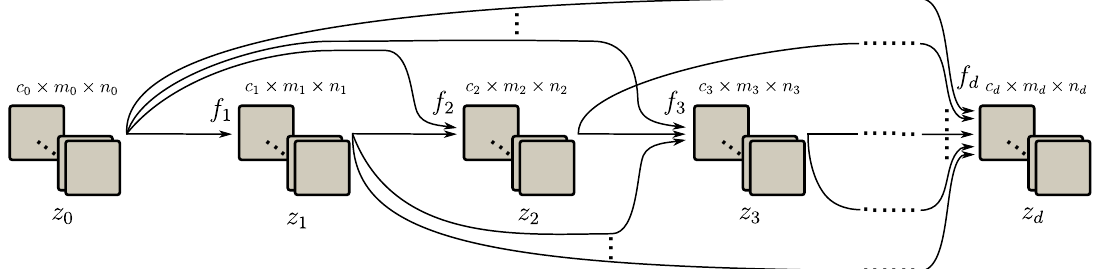
Figure 2. Schematic architecture of a neural network with dependencies between all layers. Squares denote feature map channels and arrows denote function inputs. The network depth is given by d